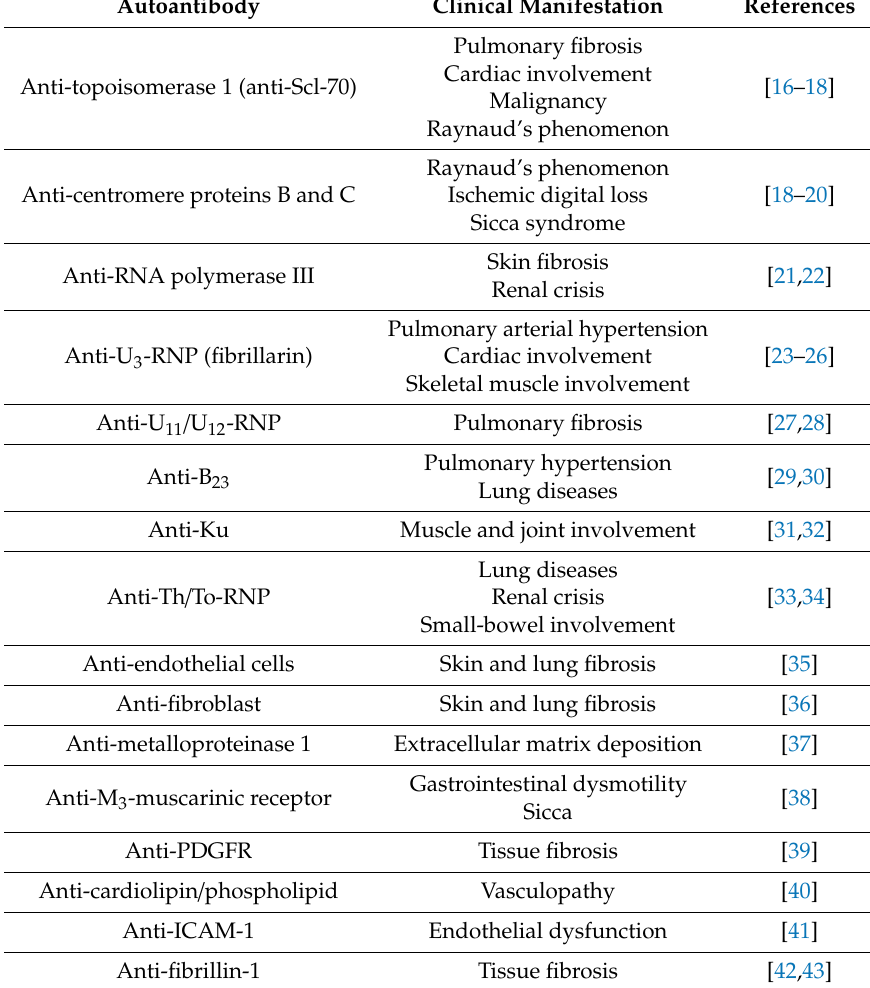
Table 1. Autoantibody-related clinical manifestations in patients with systemic sclerosis